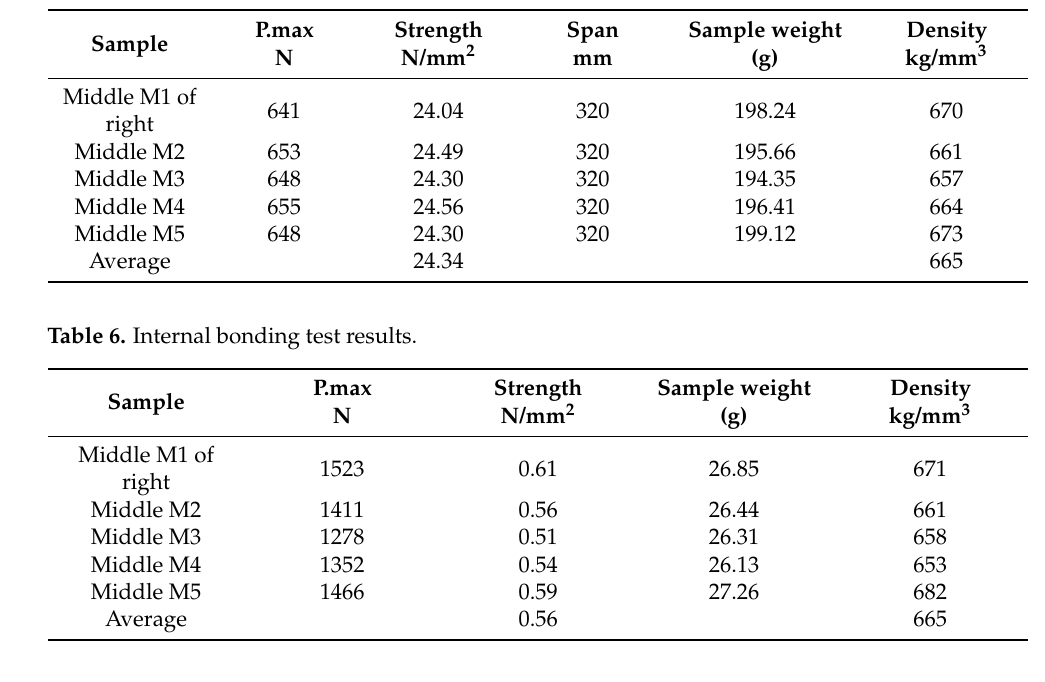
Table 8. Density profile across thickness.